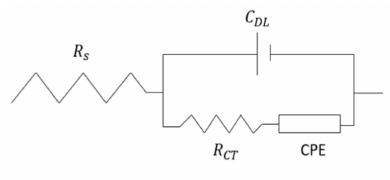
Figure 10. Randles circuit